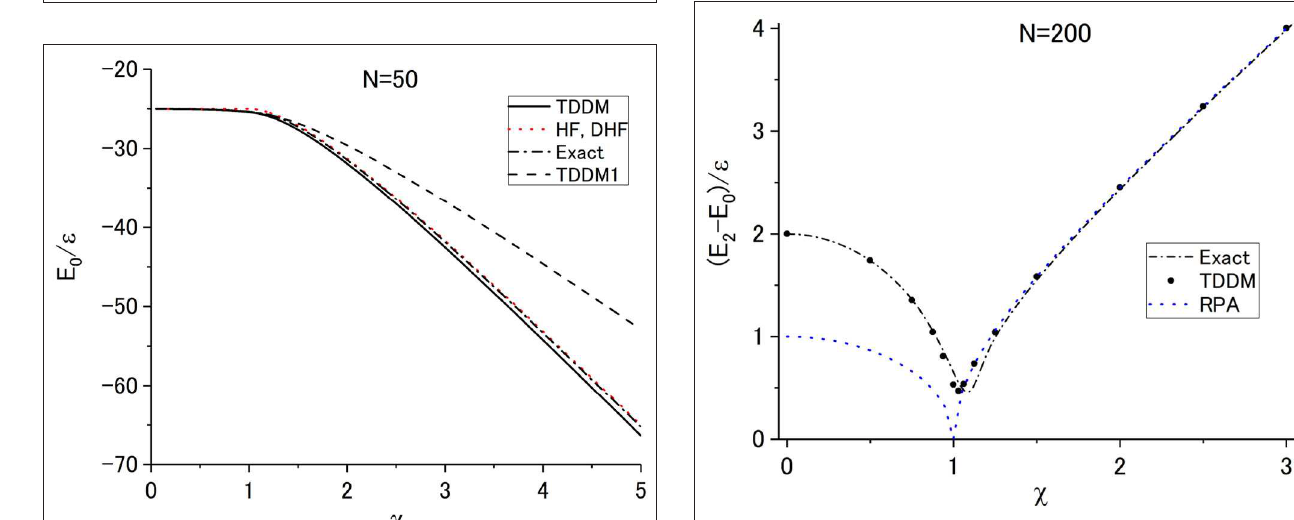
from TDDM1 to TDDM2 is not large [26]. Therefore, TDDM1 or TDDM2 may be a useful truncation scheme to be applied to realistic cases except for strongly interacting regions.